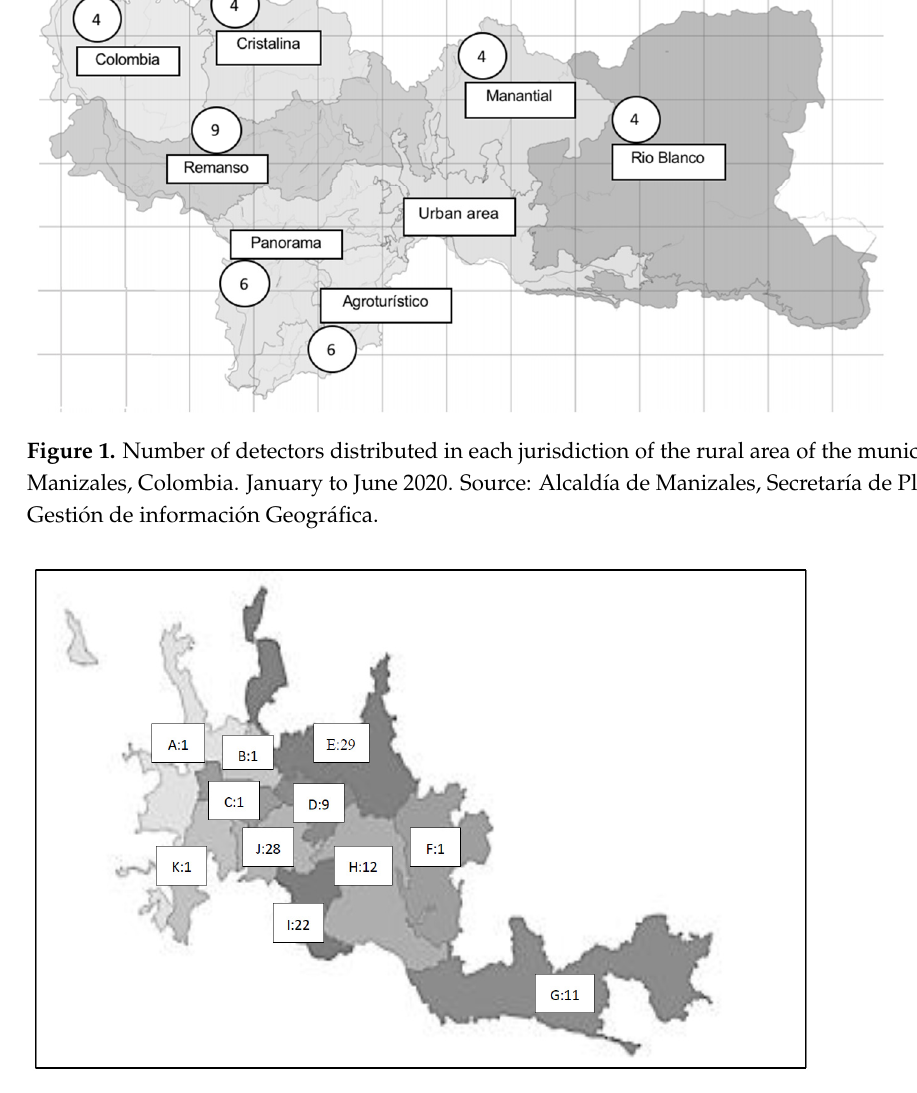
Figure 2. Number of detectors distributed in each commune of the urban area of the municipality of Manizales, Colombia. January to June 2020. The communes that appear on the map are: Atardeceres ( A ), San José ( B ), Cumanday ( C ), La Estación ( D ), Ciudadela del Norte y Comuna 12 ( E ), Ecotur í stico Cerro de Oro ( F ), Tesorito ( G ), Palogrande ( H ), Universitaria ( I ), La Fuente ( J ), and La Macarena ( K ). Source: Alcald í a de Manizales, Secretar í a de Planeaci ó n, Gesti ó n de informaci ó n Geogr á